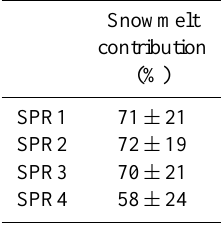
Table 5. Average (three years) snowmelt contribution to ground- water recharge based on δ 2 H data. The ± uncertainty at 70% is reported after each